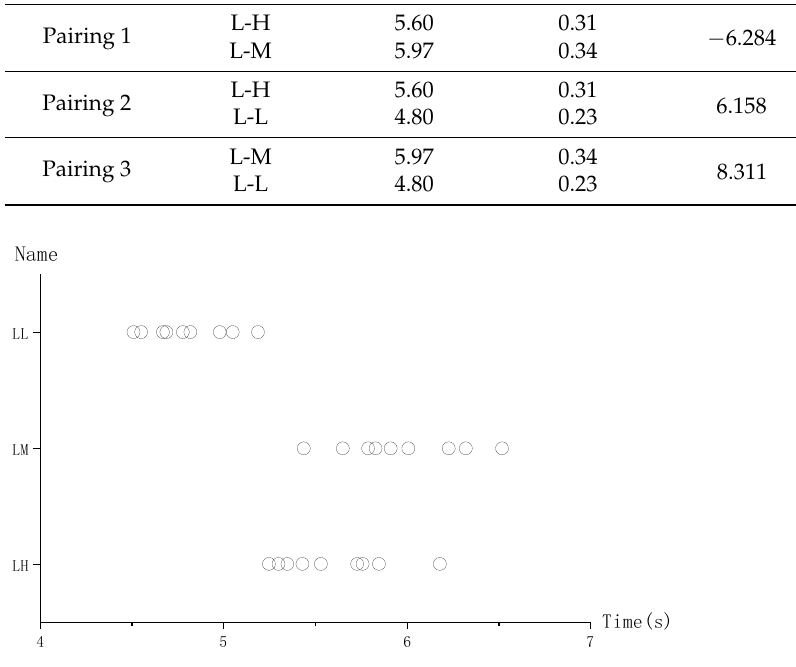
Figure 15. Scatter plot of the response time for each height of the low-pitched indication.